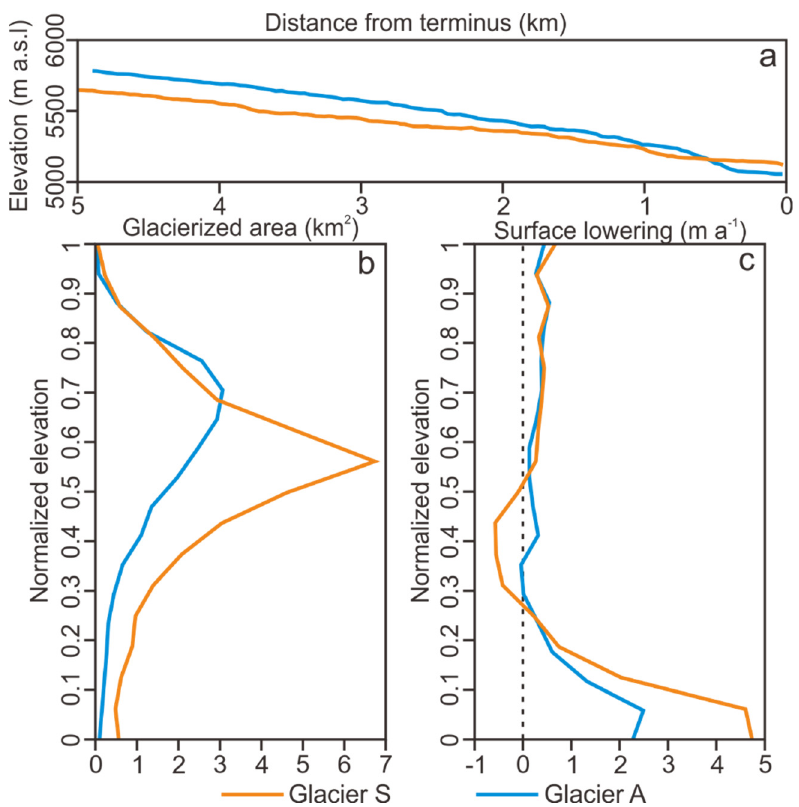
Figure 6. Topographic and hypsometry profiles of the studied glaciers: ( a ) surface elevation profiles in real slope ratio measured in 2000, ( b ) glacier hypsometry curves measured in 2000, and ( c ) surface elevation change curves between 2000 and 2015.